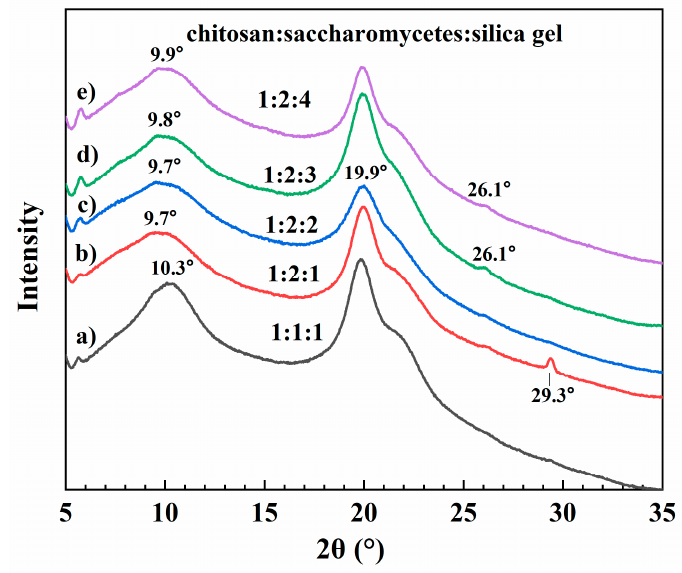
Figure 7. XRD pattern of the porous chitosan/saccharomycetes microspheres with different ratio of chitosan to saccharomycetes and silica gel of 1:1:1 ( a ), 1:2:1 ( b ), 1:2:2 ( c ), 1:2:3 ( d ), and 1:2:4 ( e ).